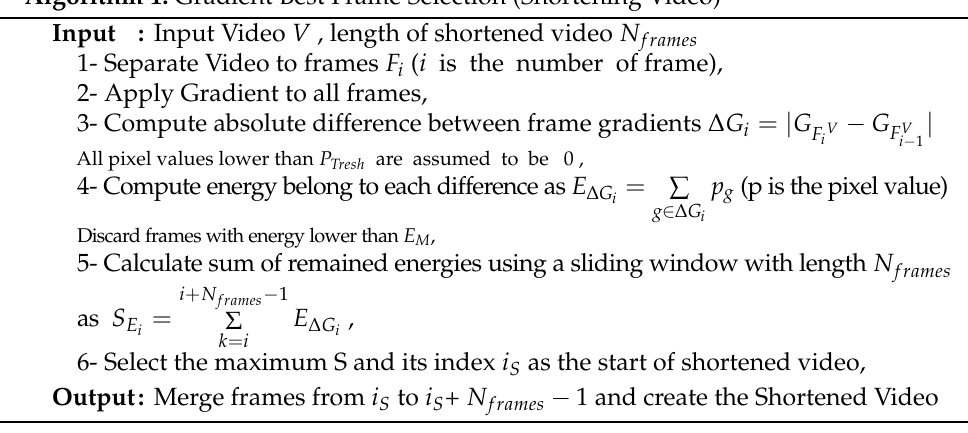
Algorithm 1: Gradient Best Frame Selection (Shortening Video)